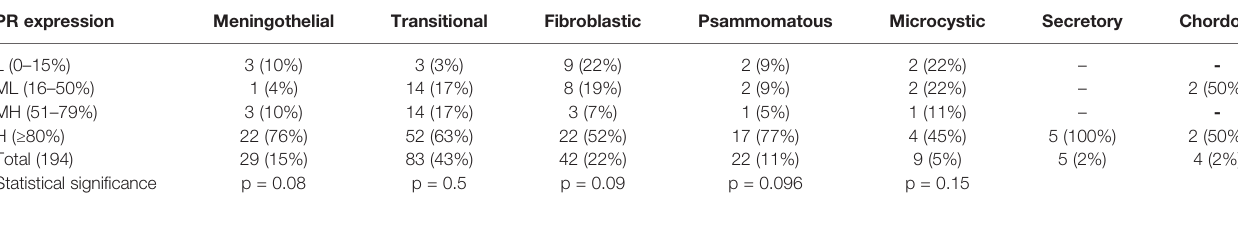
TABLE 6 | PR expression and histological type of 194 WHO grade I meningiomas.